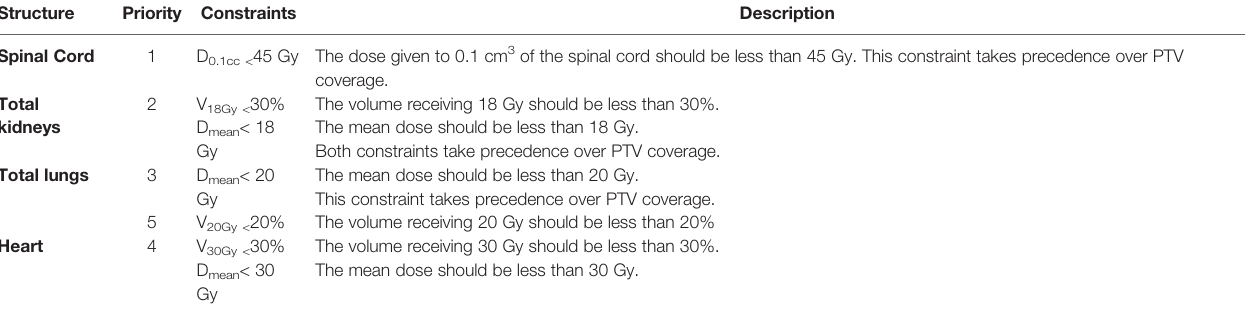
TABLE 1 | Dose constraints. Structure Priority Constraints